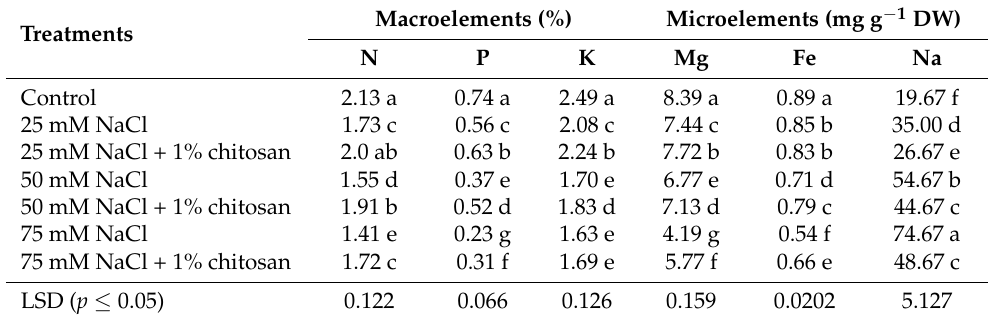
Table 1. Effect of salinity levels and chitosan application on the mineral content of Moringa oleifera L. plant.